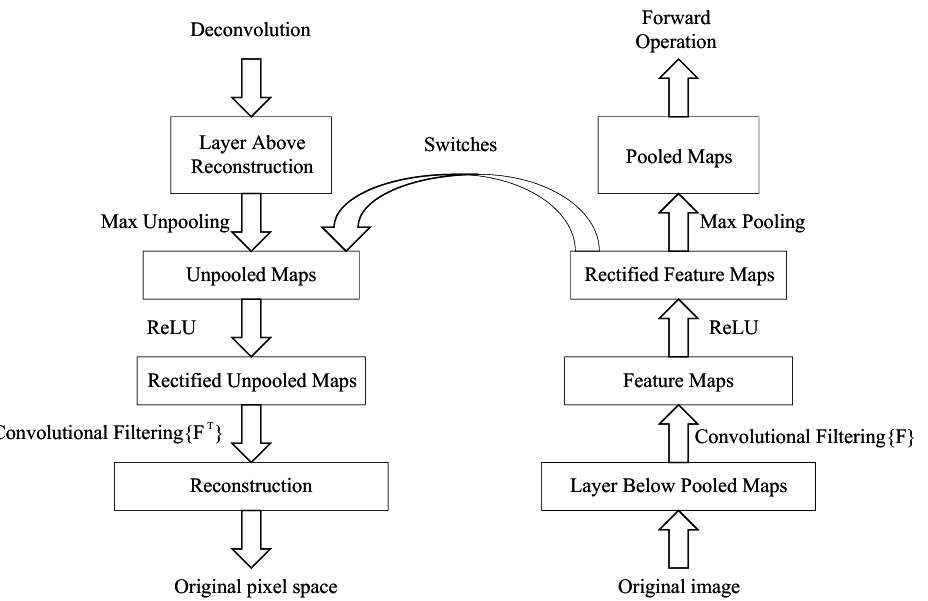
Figure 5. Schematic diagram of the